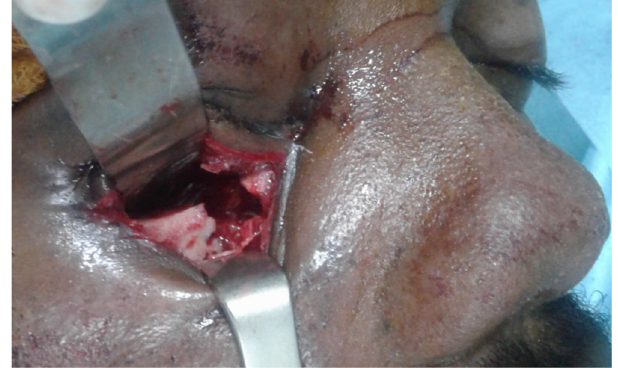
Fig. 3. “ Impure ” fl oor fracture with more than 50% substance loss from the fl oor, medial palpebral approach